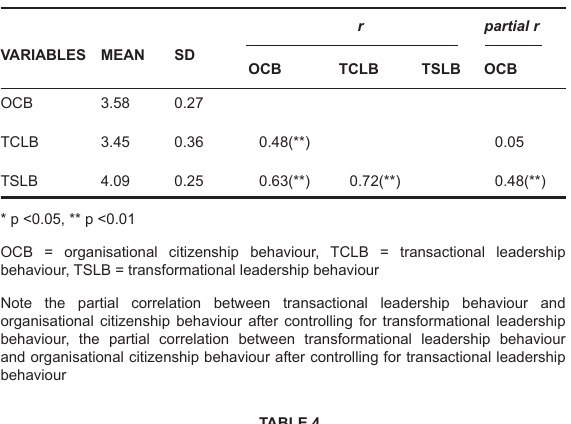
TABLE 3 Means, standard deviations, zero order and partial correlations for study